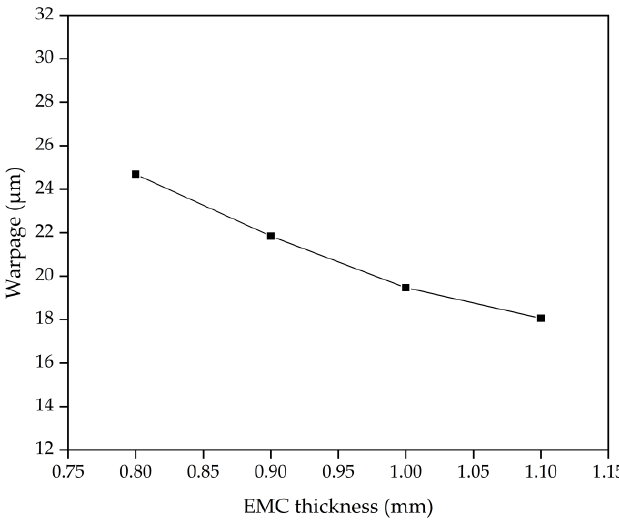
Figure 14. Influence of EMC thickness on warpage.